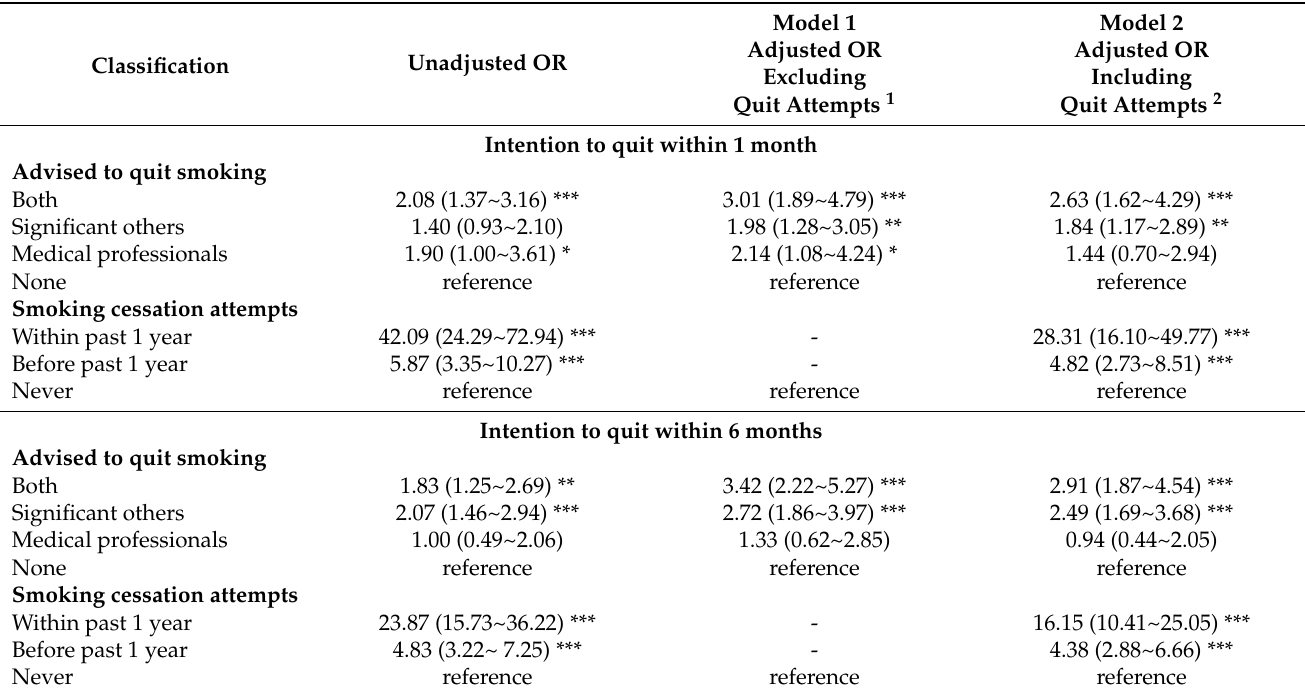
Table 2. Unadjusted and adjusted odds ratios (OR, 95% confidence interval) of intention to quit smoking compared to those who had no